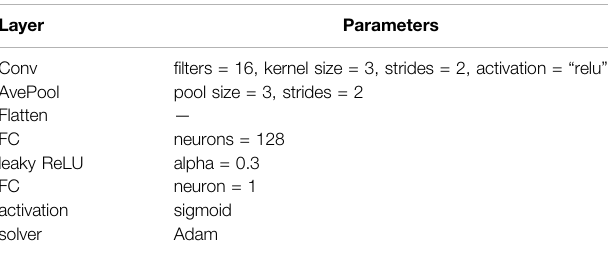
TABLE 2 | Summary of the parameters of the